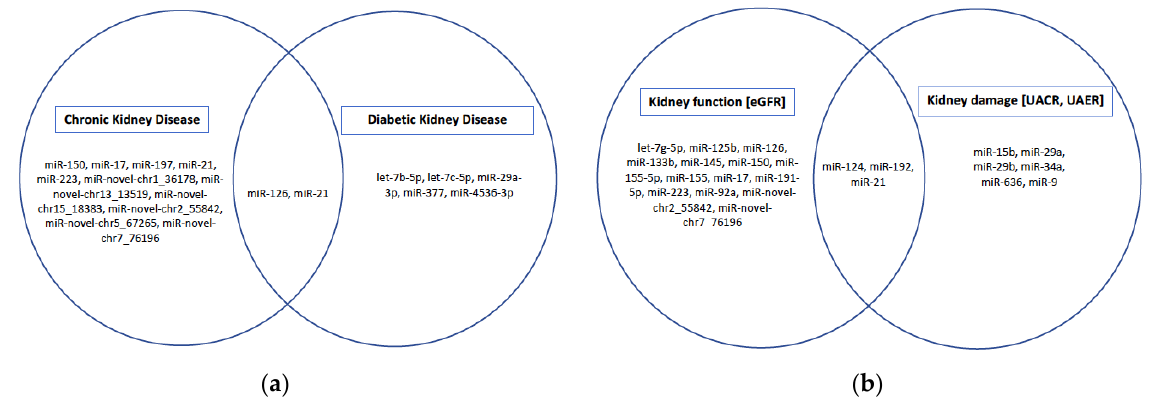
Figure 2. Associations between miRNAs and CKD subgroups and markers of kidney function and damage. ( a ) Shows miRNAs independently associated with CKD in general population and in high-risk individuals with HTN and DM. ( b ) miRNAs associated with markers of kidney function and or kidney damage in general population and in high-risk individuals with HTN and DM.